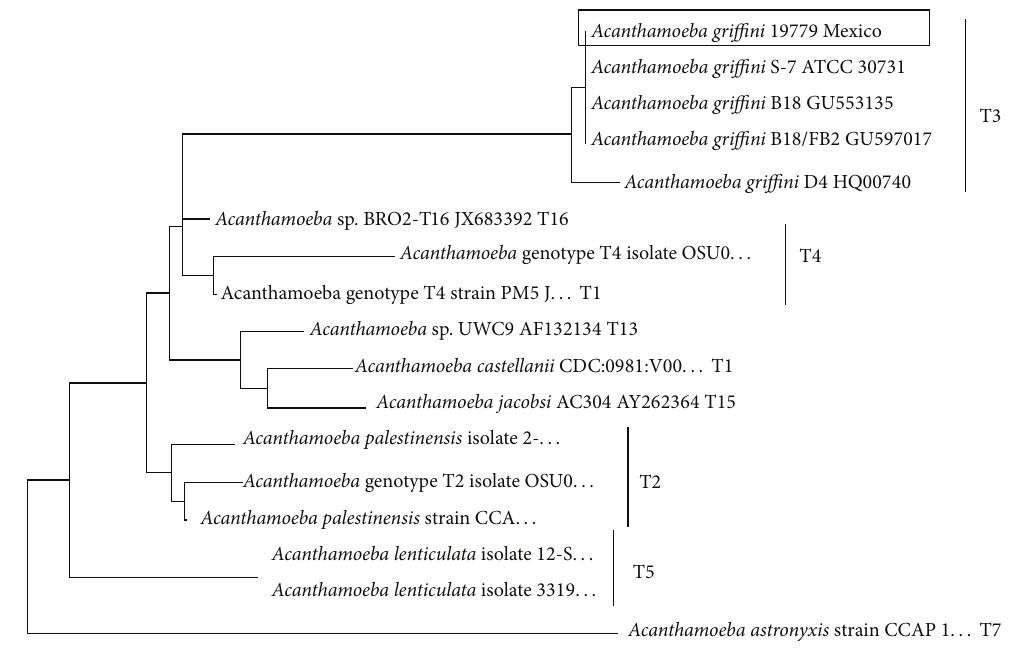
Figure 4: 18S rRNA DF3 linearized Neighbour-Joining tree. The phylogenetic analysis was performed using the Kimura two-parameter distance algorithm in MEGA 5.0. The isolate obtained in the present study is identified in the tree (box). The type sequences were taken from GenBank and are presented under the following numbers: A. astronyxis strain CCAP 1534/1 genotype T7 Accession number AF239293, A. castellanii strain genotype T1 CDC:0981:V006 Accession number U07400, A. griffini S-7 ATCC 30731 genotype T3 Accession number U07412, A. griffini isolate B18 genotype T3 Accession number GU553135, A. griffini isolate B18/FB2 genotype T3 Accession number GU597017, A. griffini isolate D4 genotype T3 Accession number HQ00740, A. lenticulata isolate 12-SO #KC694184, A. lenticulata isolate 33195463